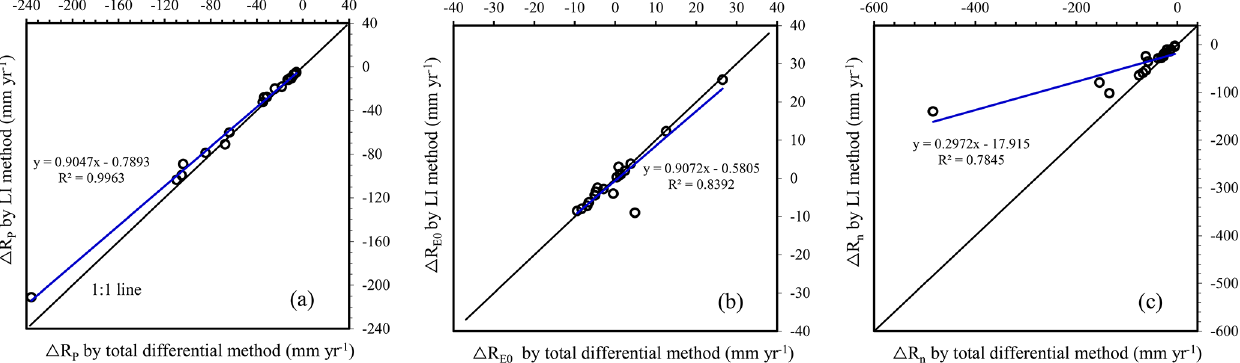
∂R ∂R ∂R ∂R d n = (cid:82) d n + (cid:82) d n = 0 + (cid:82) d n = AB + BC AB BC BC ∂n ∂n ∂n ∂n